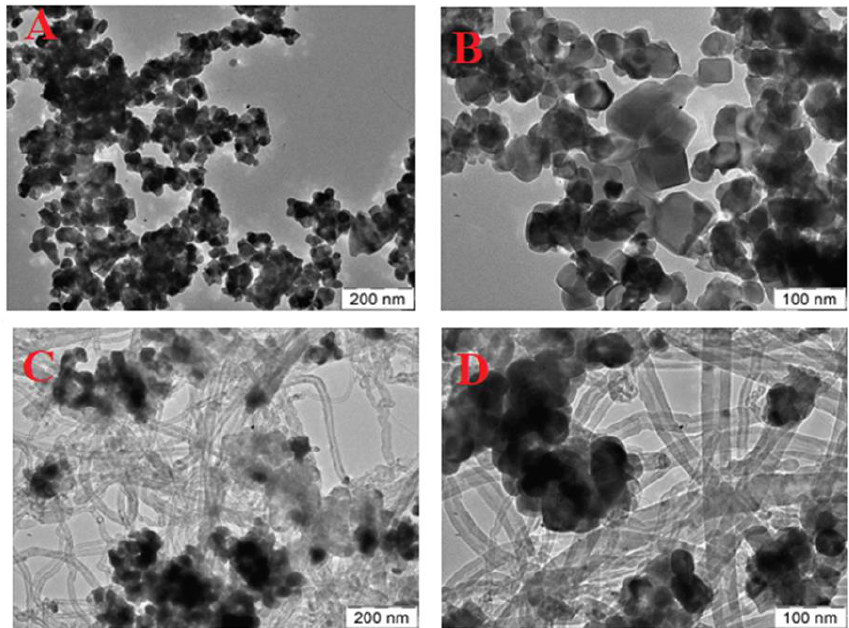
Figure 6. TEM image of ( A ) fresh 5Ni-10 La 2 O 3 -ZrO 2 catalyst, ( B ) fresh 5Ni-10 La 2 O 3 -ZrO 2 catalyst, ( C ) used 5Ni-10 La 2 O 3 -ZrO 2 catalyst, and ( D ) used 5Ni-10 La 2 O 3 -ZrO 2 catalyst.